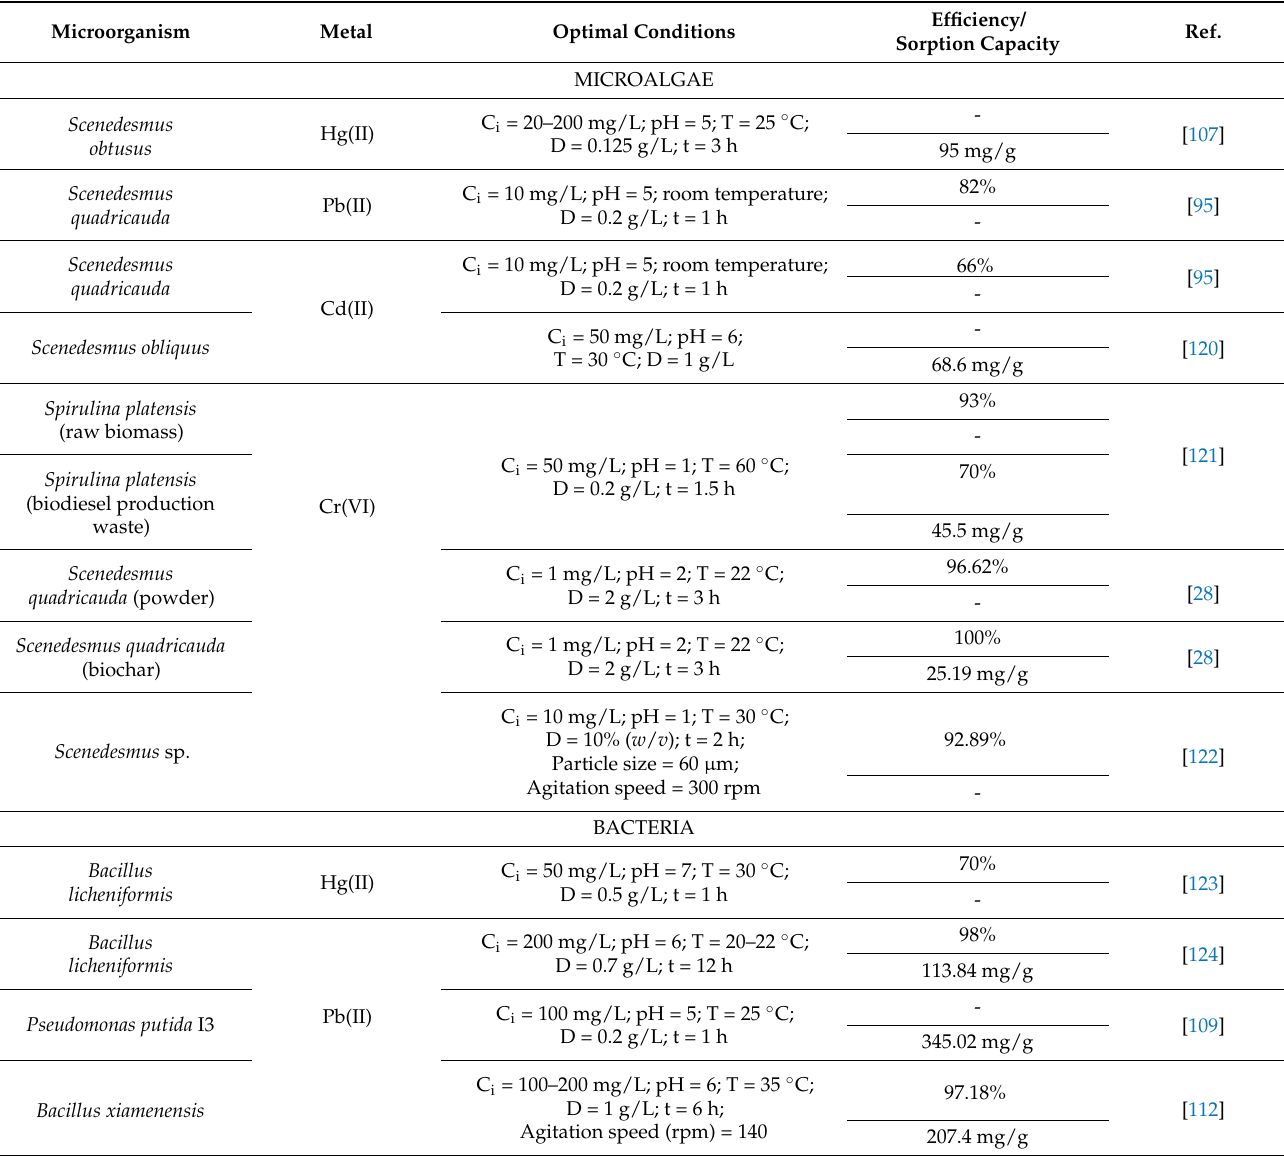
Table 2. Heavy metals removal by microbial inactive